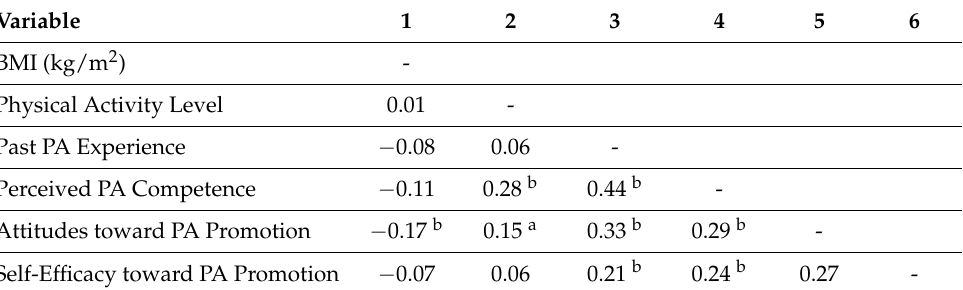
Table 3. Correlation Table.